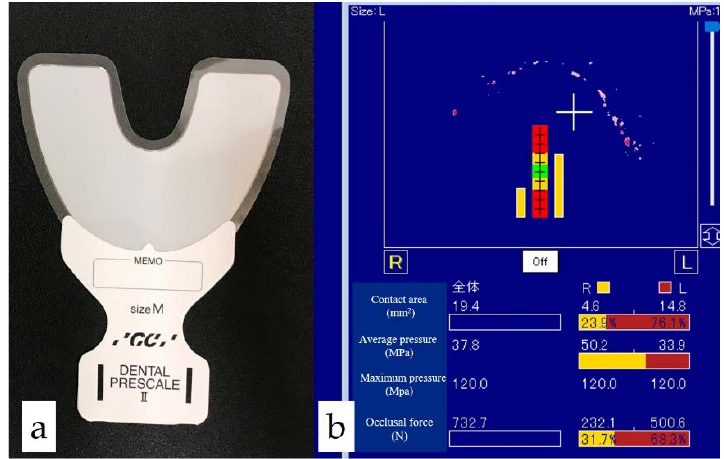
Figure 2. Occlusal force measurement system: ( a ) pressure-sensitive sheet (Dental Prescale II); ( b ) image of occlusal condition using software (bite force analyzer).